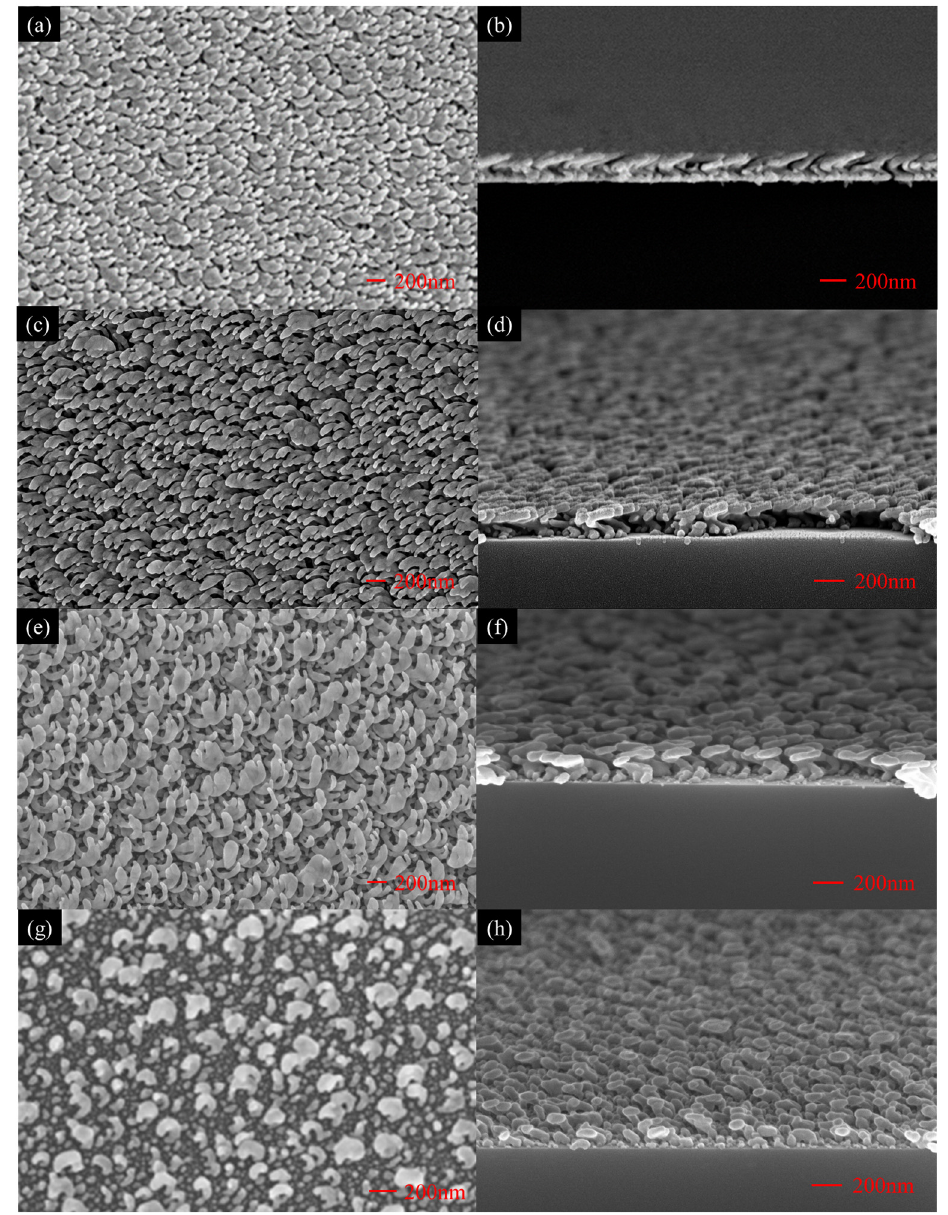
Figure 3. Top ‐ view and cross ‐ section SEM images of Ag nanohelix arrays deposited at deposition Figure 3. Top-view and cross-section SEM images of Ag nanohelix arrays deposited at deposition angles of ( a , b ) 80°; ( c , d ) 83°; ( e , f ) 86° and ( g , h ) 89°. angles of ( a , b ) 80 ◦ ; ( c , d ) 83 ◦ ; ( e , f ) 86 ◦ and ( g , h ) 89 ◦